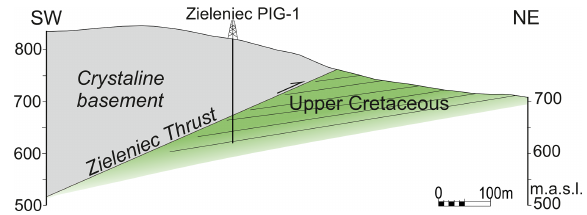
Figure 16. Schematic section across the Zieleniec Thrust (based on data from Cymerman, 1990, and Kozdrój, 2014). Location in Figs. 2 and